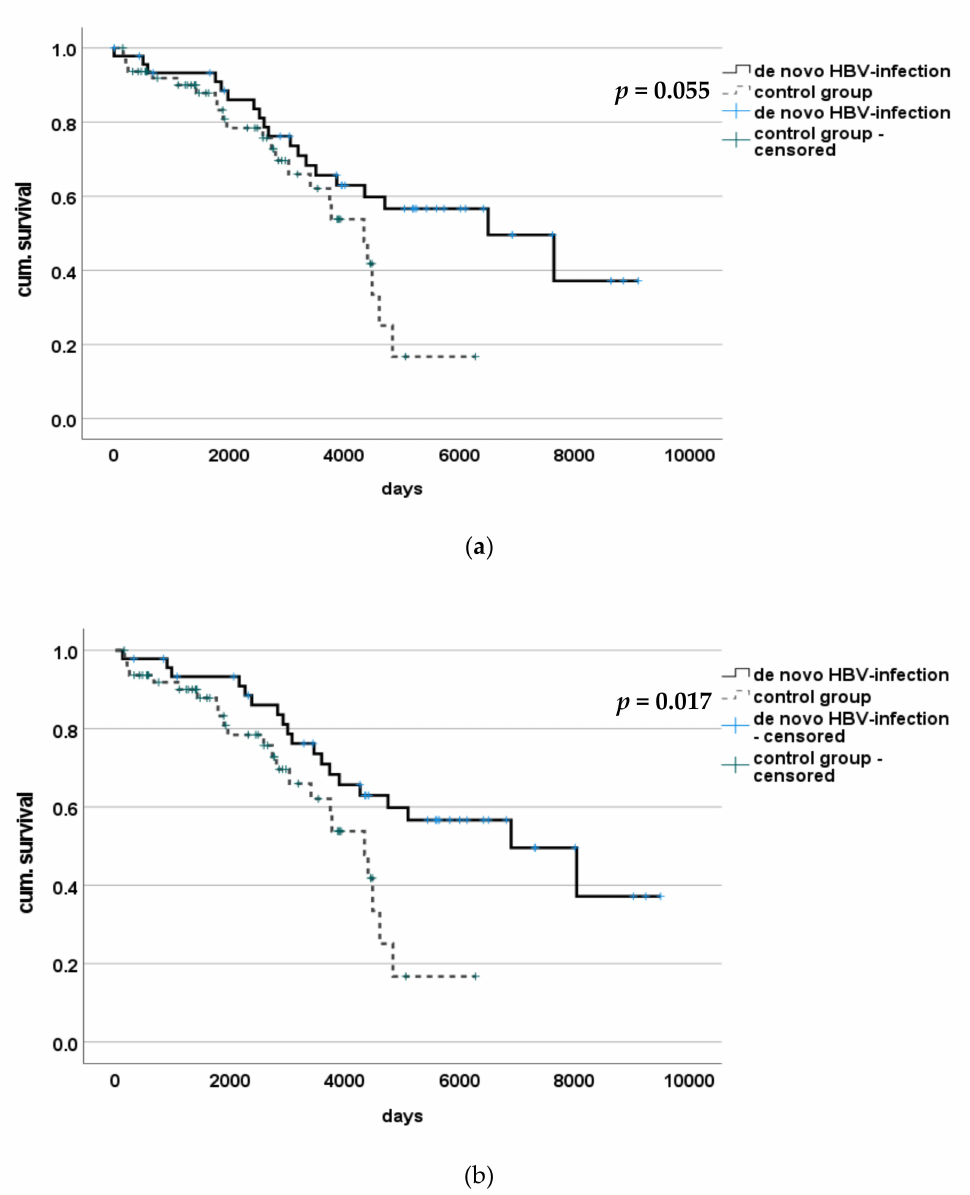
Figure 5. Survival of patients with or without de novo HBV-infection after LT. ( a ) Statistical significant difference in overall survival after liver transplantation was found between patients with de novo HBV-infection and those without. ( b ) After adjusting to median time of discontinuation (397 days) to better evaluate course after de novo HBV-infection survival did not show any significant